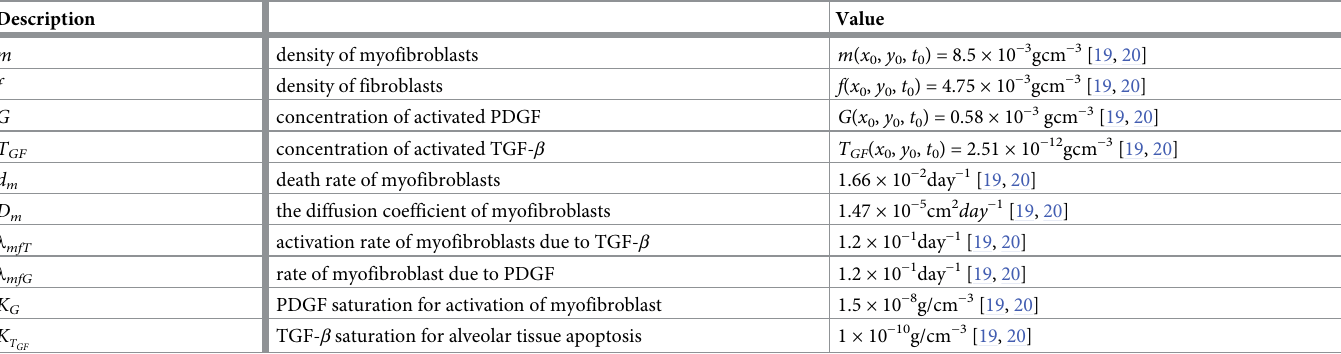
Table 1. Parameters’